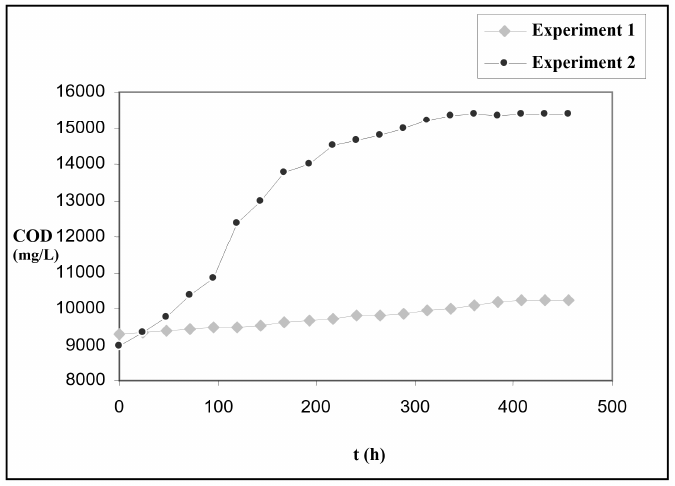
Figure 4. Biogas